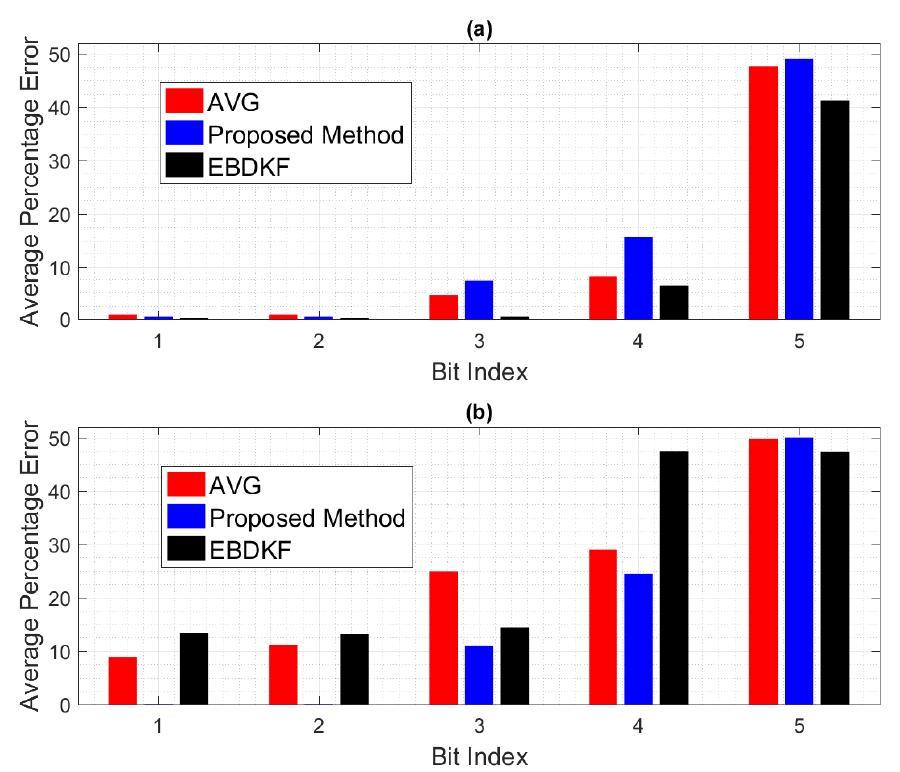
Figure 6. Bit level error performance comparison among the proposed statistical, EBDKF, and AVG information fusion methods in a chain-based IoT platform for ( a ) BER of 0.005 and ( b ) BER of